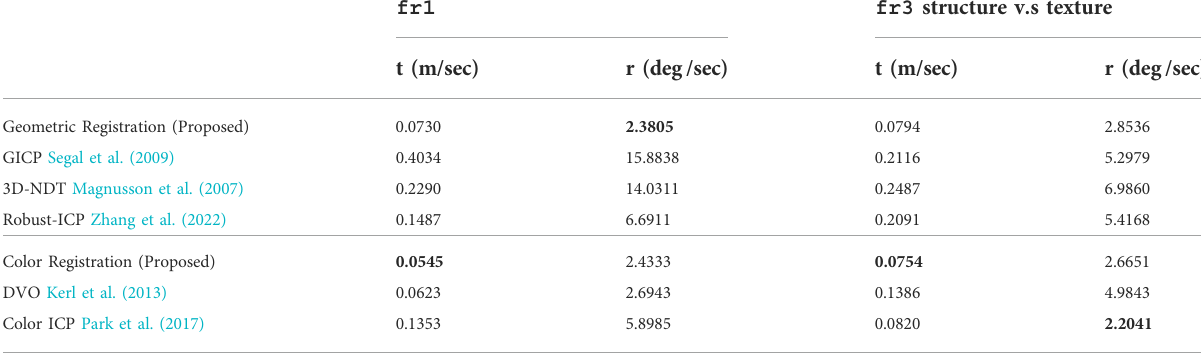
TABLE 2 The RMSE of Relative Pose Error (RPE) averaged over TUM RGB-D (Sturm et al., 2012) fr1 and fr3 structure v.s texture sequences. The t columns show the RMSE of the translational drift in m/sec and the r columns show the RMSE of the rotational error in deg /sec. The RMSE is averaged over all